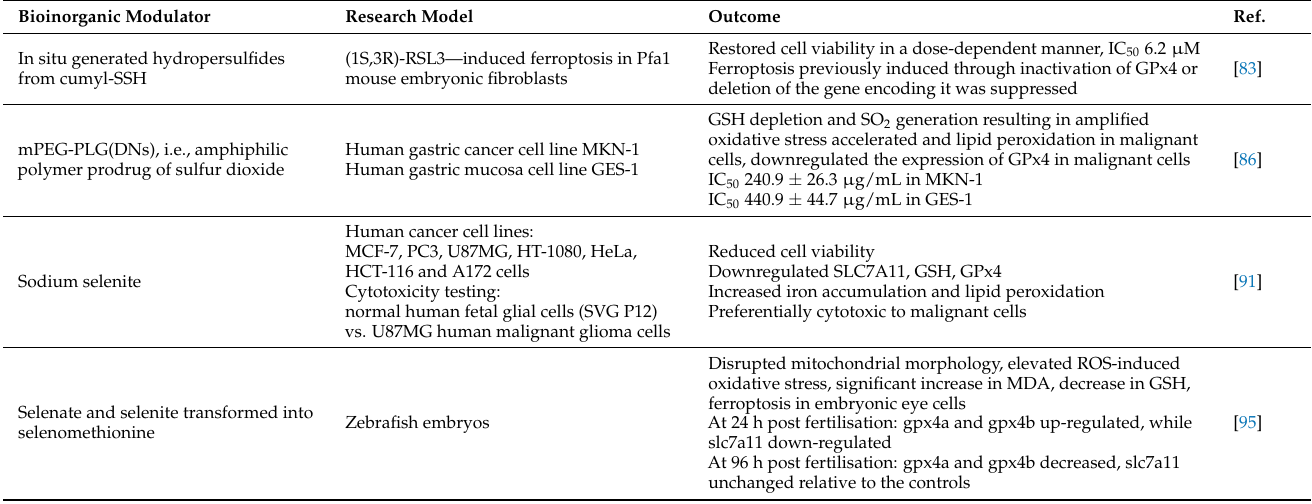
Table 2. Recapitulation of the chalcogen-based compounds and their modulatory effect on ferroptosis- related cell survival and